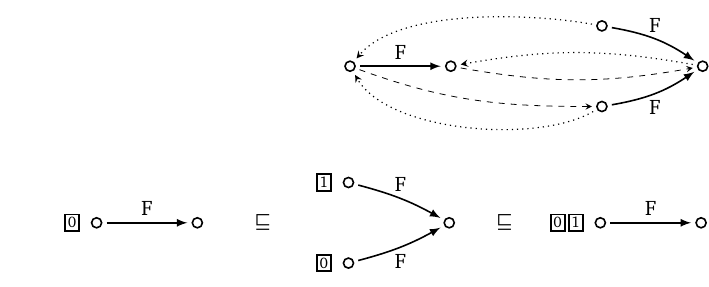
Strict subsumption between base-labelled feature